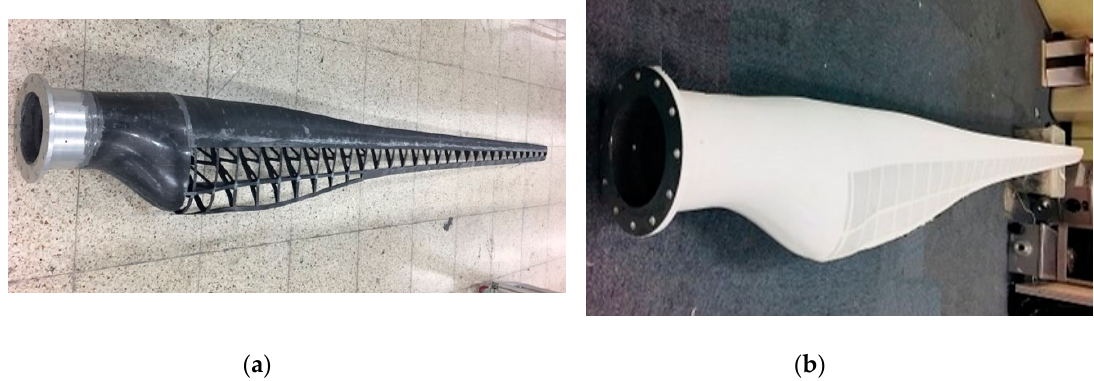
Figure 4. The fabricated fabric-covered blade: ( a ) without skin and ( b ) with skin. Table 1. The components’ mass of the fabric-covered blade.